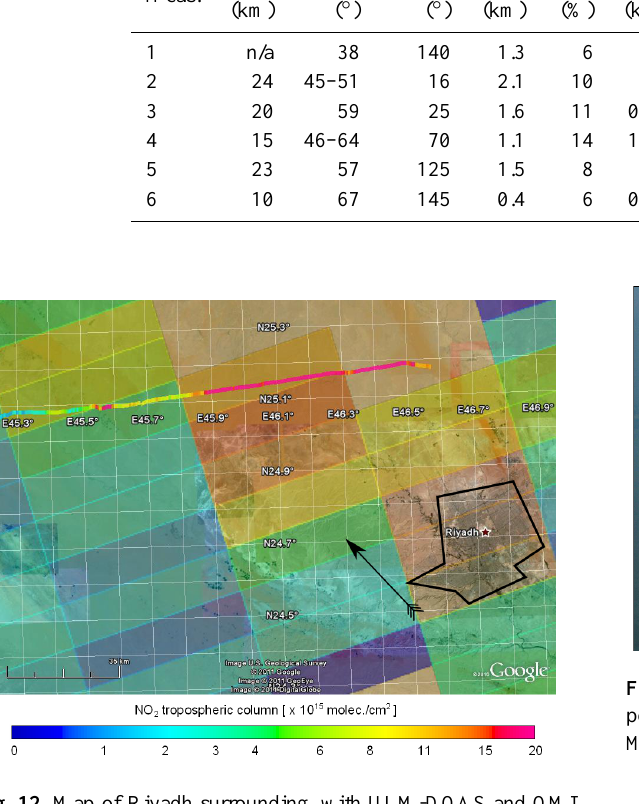
Fig. 12. Map of Riyadh surrounding, with ULM-DOAS and OMI NO 2 data superimposed. Riyadh agglomeration is delimited by the black polygon. The arrow indicates the wind direction according to the GDAS archive.